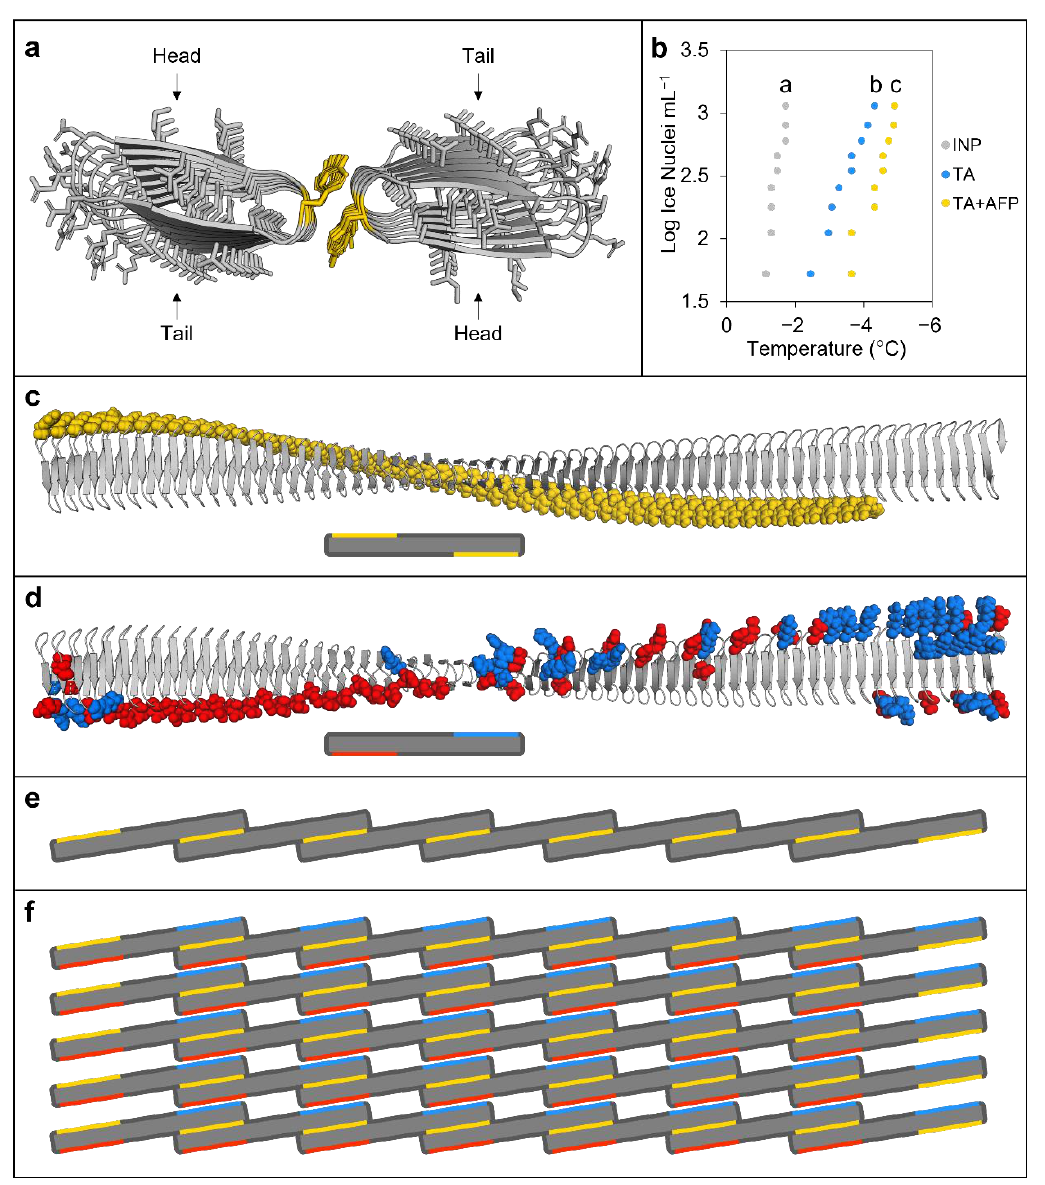
Figure 3. Modelling and other experimental evidence of ice nucleating protein (INP) interactions. ( a ) Tyrosine ladder interactions between INP monomers (InaZ) as predicted by FRODOCK using AlphaFold models, with tyrosine residues (in yellow) showing head-to-tail dimerisation. ( b ) Ice nucleation assay comparing INP preparations at 50 µ g mL − 1 alone (grey dots) or combined